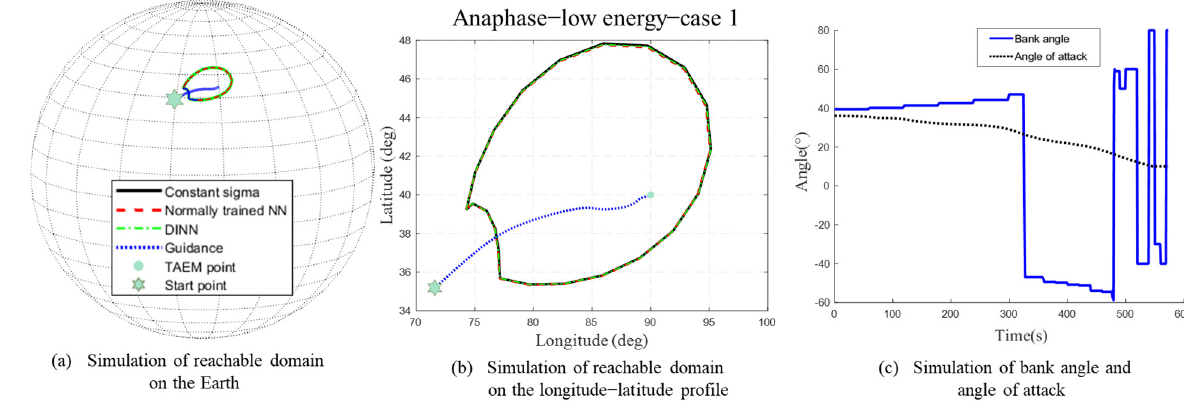
Figure 10. Simulation of low energy Case 1.